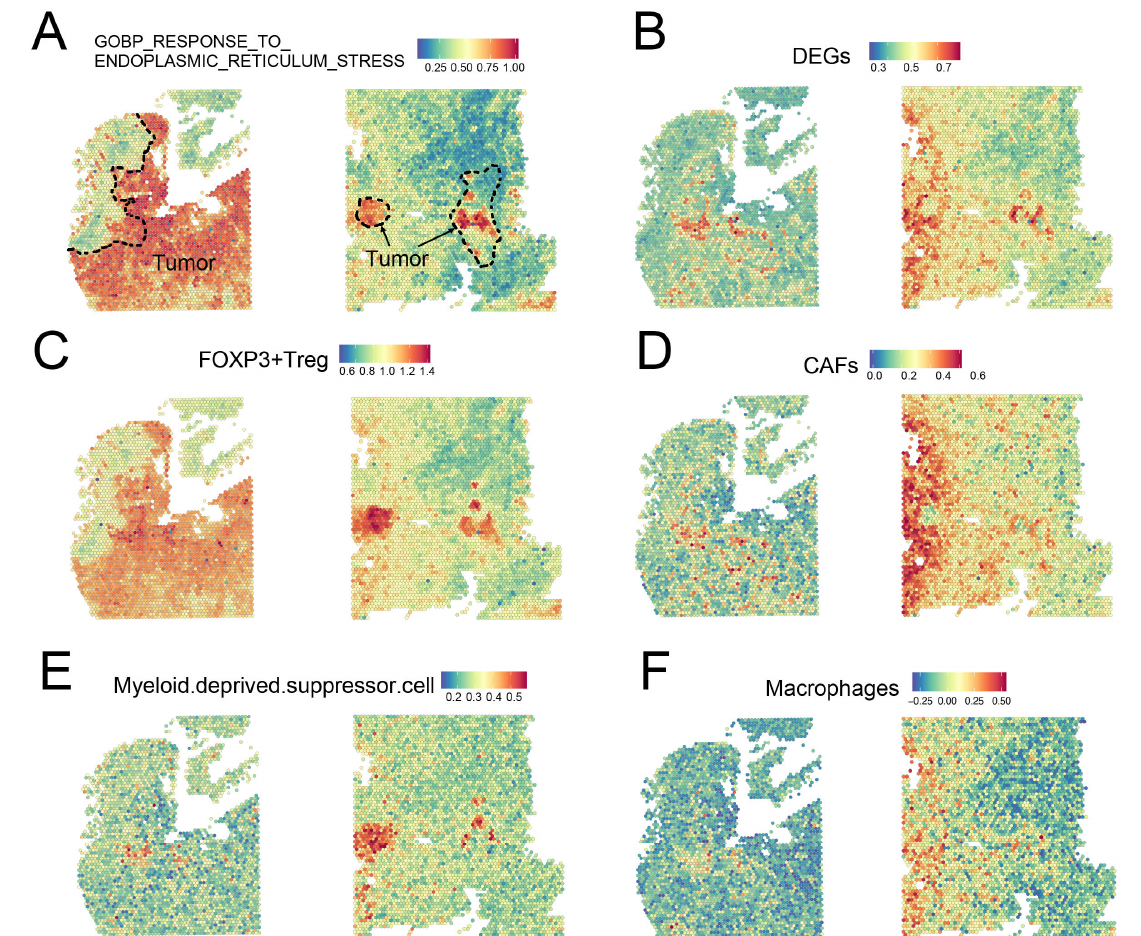
Figure 8. Mapping of gene signatures ER stress and immune cells on CRC ST data. ( A ) The enrichment score of GOBP_RESPONSE_TO_ENDOPLASMIC_RETICULUM_STRESS gene set on ST data; the dotted line represents the tumor region. ( B ) Enrichment score of DEGs between ERcluster A and B on ST data. ( C – F ) Enrichment score of FOXP3+ Treg, CAFs, MDSC, and Macrophages signatures on ST